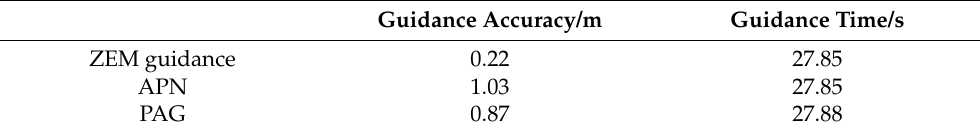
Figure 18. The flight trajectories of the missile and the target with square wave maneuver. Table 5. Performances of different guidances with square wave maneuver.